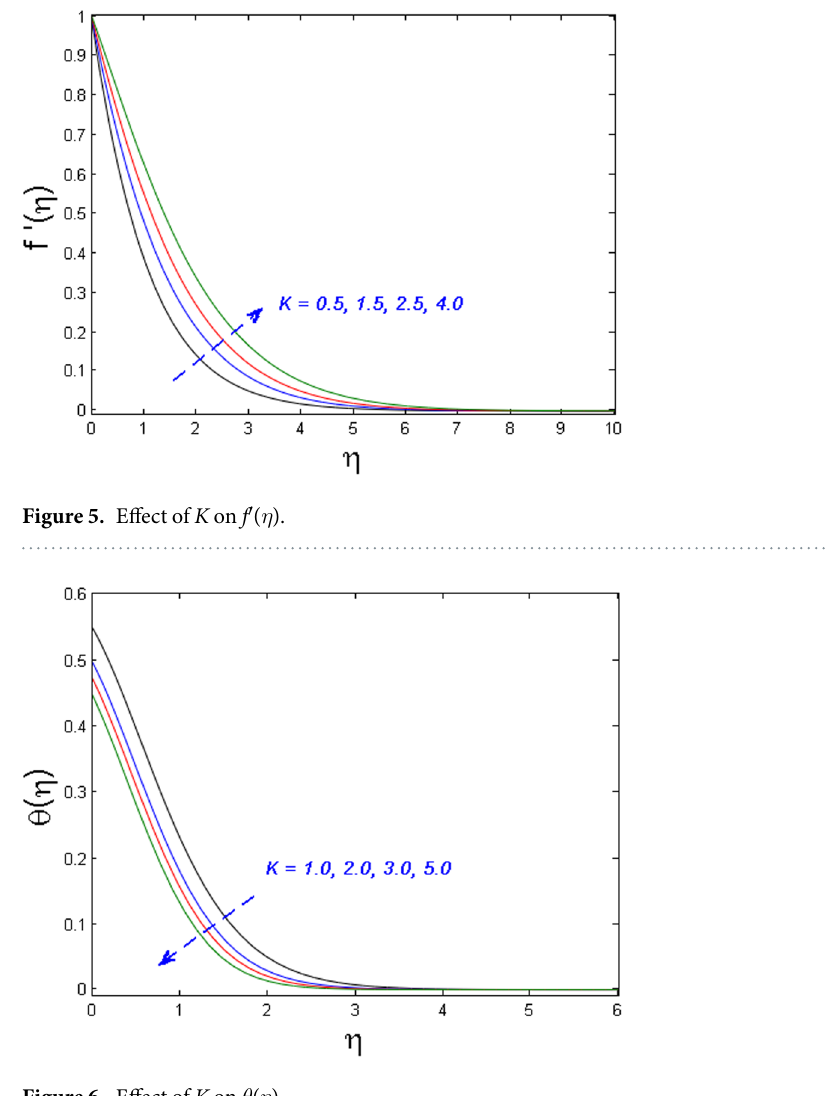
Figure 6. Effect of K on θ ( η ).